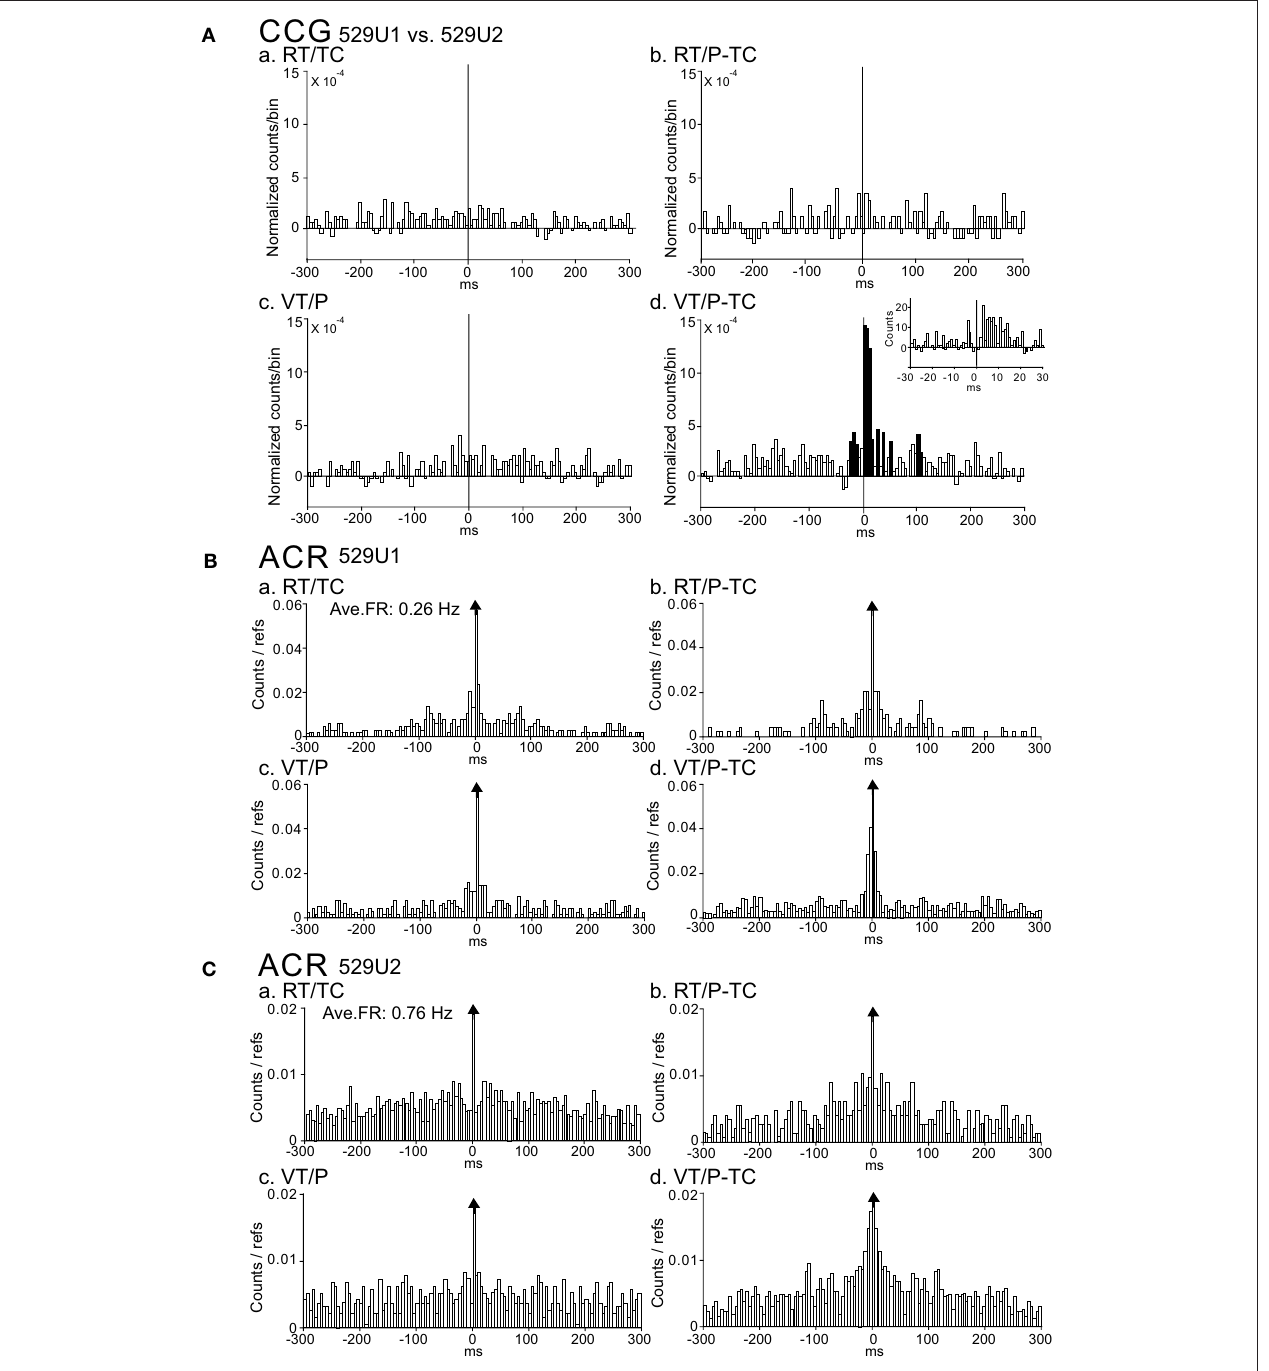
spike counts of the referenced cell (spike counts in each bin of the CCR histograms were divided by both sums of the reference and target cell discharges). Abscissa; time difference from each spike of the reference cell to that of the target cell. (B,C) ACRs of the same neurons in (A) [ (B) 529U1; (C) 529U2]. Note a sharp peak in 529U1, and a broad peak in 529U2. It is noted that 529U1 and 529U2 were not complex spike cells. Ave. FR, average frequency of a neuron across the four tasks. Ordinate, spike counts of the cell. Abscissa; time difference from each reference spike to each spike of